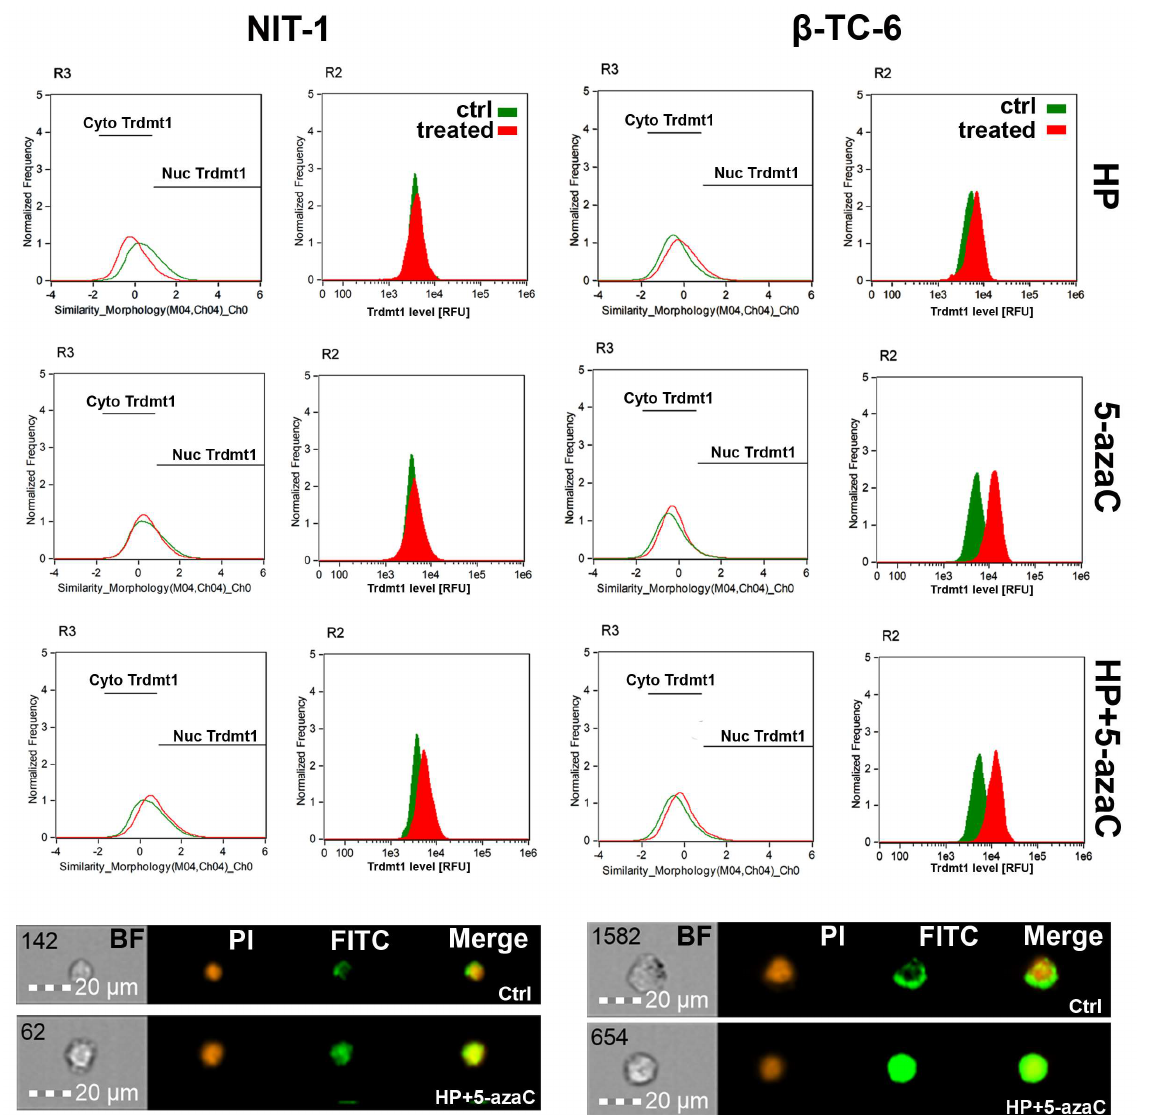
Figure 4. 5-AzaC post-treatment-mediated changes in the levels and intracellular localization of Trdmt1 in hydrogen peroxide-treated mouse insulinoma NIT-1 ( left ) and β -TC-6 cells ( right ). Insulinoma cells were stimulated with 100 µ M HP for 24 h and then post-treated with 1 µ M 5-azaC for 24 h. To analyze Trdmt1 signals, immunofluorescence and imaging flow cytometry were used. Representative histograms are shown ( top ). Green histograms indicate untreated samples and red histograms indicate treated samples. Cytoplasmic (Cyto) and nuclear (Nuc) signals of Trdmt1 are denoted using black horizontal lines. Representative images are also shown ( bottom ). BF, bright field; PI, nucleus staining using propidium iodide staining (red); FITC, immunostaining of Trdmt1 using secondary antibody conjugated to Alexa Fluor Plus 488 (green); Merge, a merged image of PI and FITC. Ctrl, control conditions; HP, hydrogen peroxide (H 2 O 2 ) treatment; 5-azaC, azacytidine treatment; HP+5-azaC, hydrogen peroxide treatment, and azacytidine post-treatment. On the contrary, HP stimulation in β -TC-6 cells promoted an increase in the levels of Trdmt1 that was potentiated after 5-azaC post-treatment (Figure 4). 5-AzaC alone also caused elevated levels of Trdmt1 in β -TC-6 cells (Figure 4). All treatments in β -TC-6